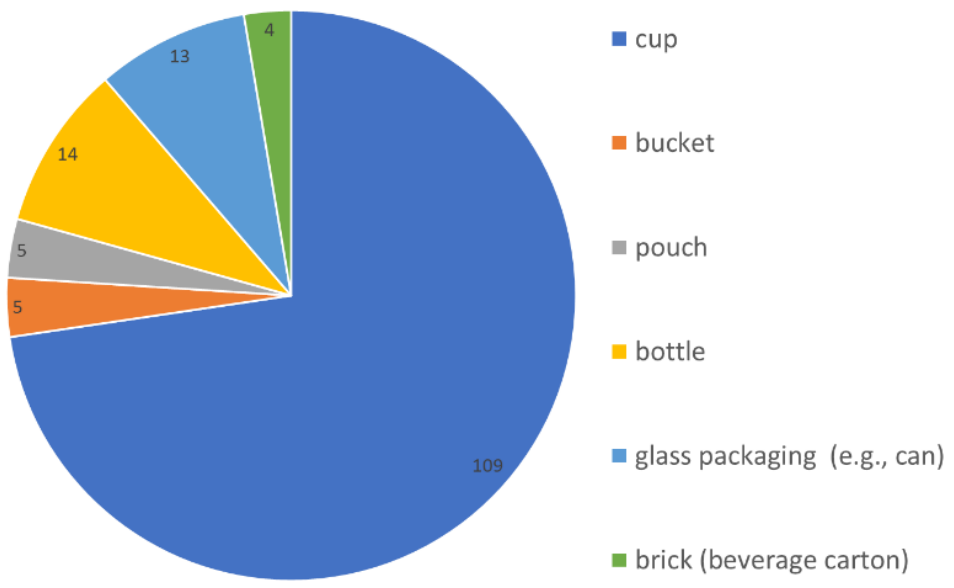
Figure 3. Analysed packaging mean categories; numbers: number of samples, n = 150 .